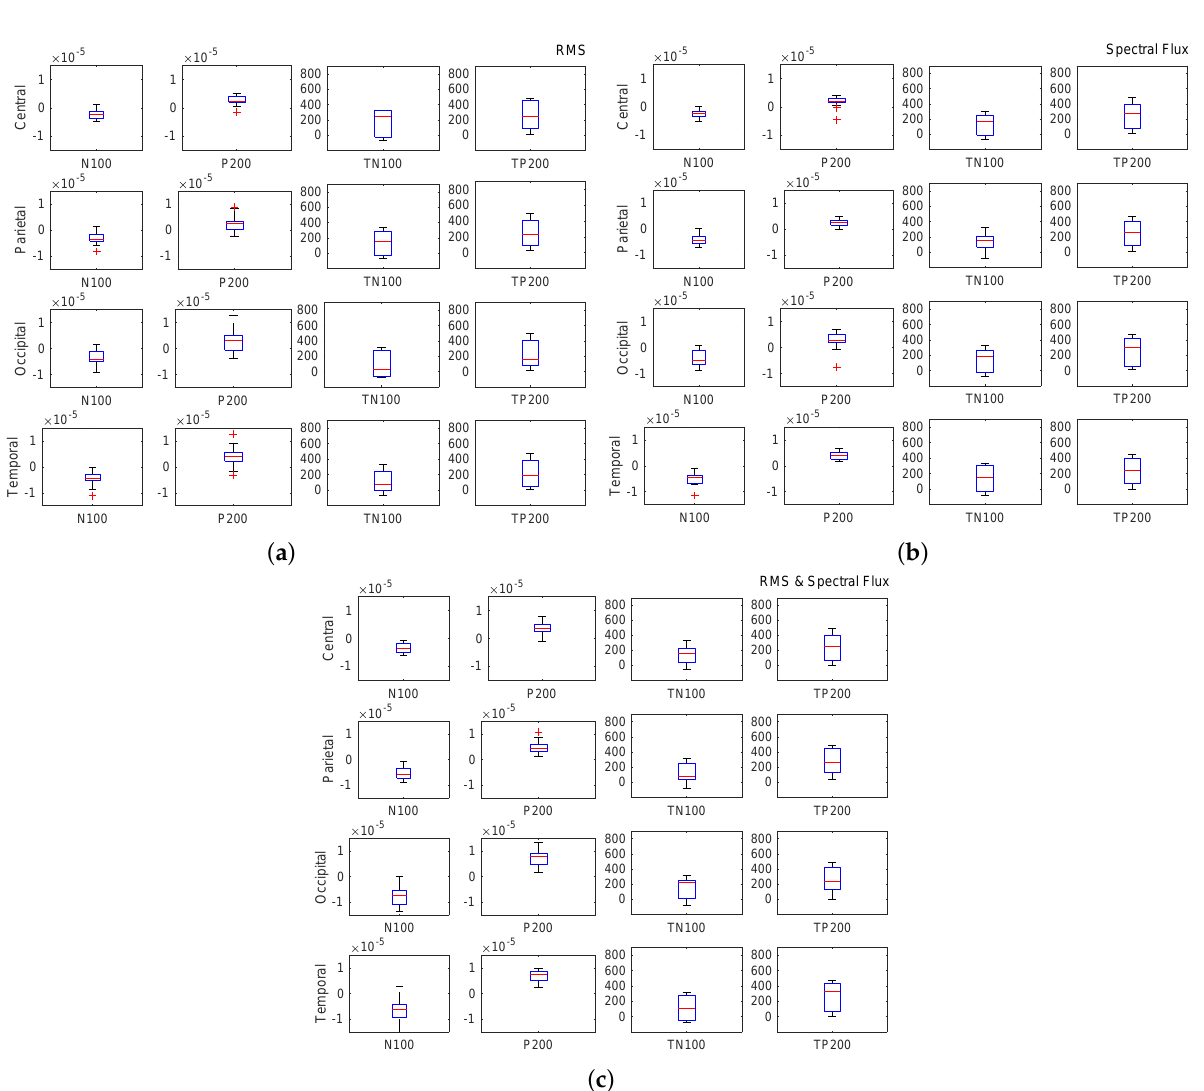
Figure 2. ( a ) Box-plot distributions of the N100 and P200 amplitudes (N100, P200) and latencies (TN100, TP200) due to RMS changes. ( b ) Box-plot distributions of the N100 and P200 amplitudes (N100, P200) and latencies (TN100, TP200) due to spectral flux changes. ( c ) Box-plot distributions of the N100 and P200 amplitudes (N100, P200) and latencies (TN100, TP200) due to coterminous RMS and spectral flux